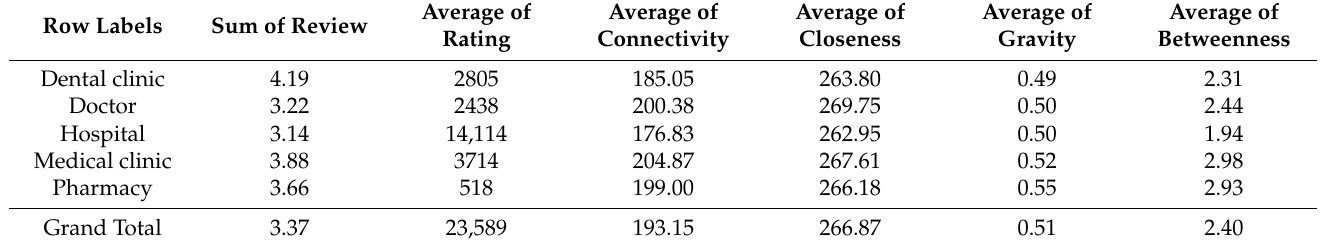
Table 10. Health Facility Service Perception and 400 m Radius Area Configuration according to Google POI.